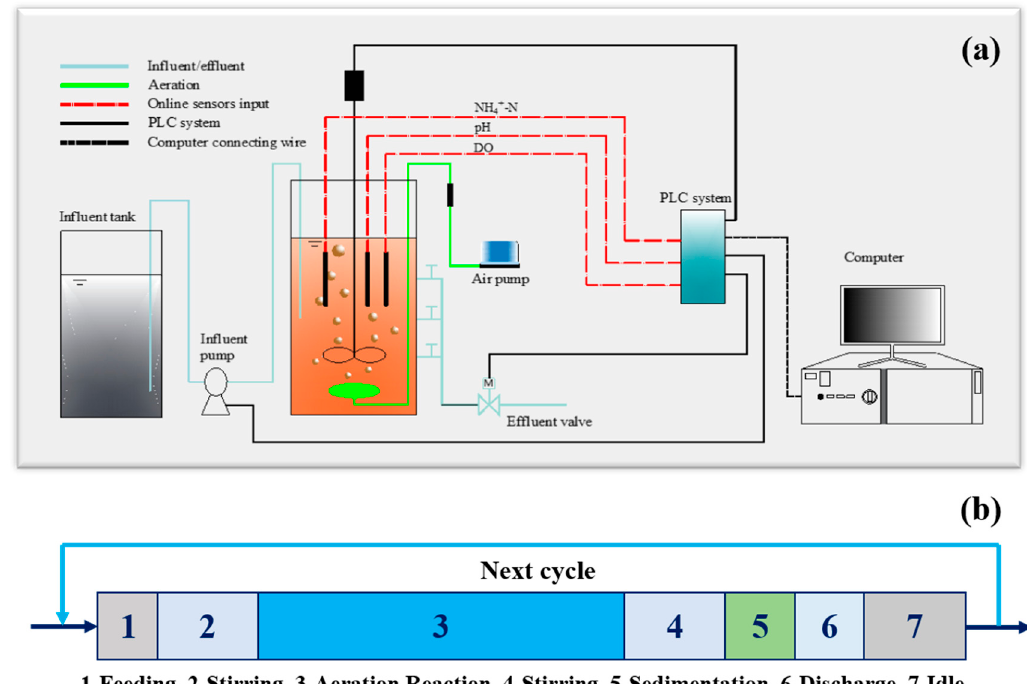
Figure 1. Experimental set-up ( a ) and operational pattern ( b ) of the CPNA.